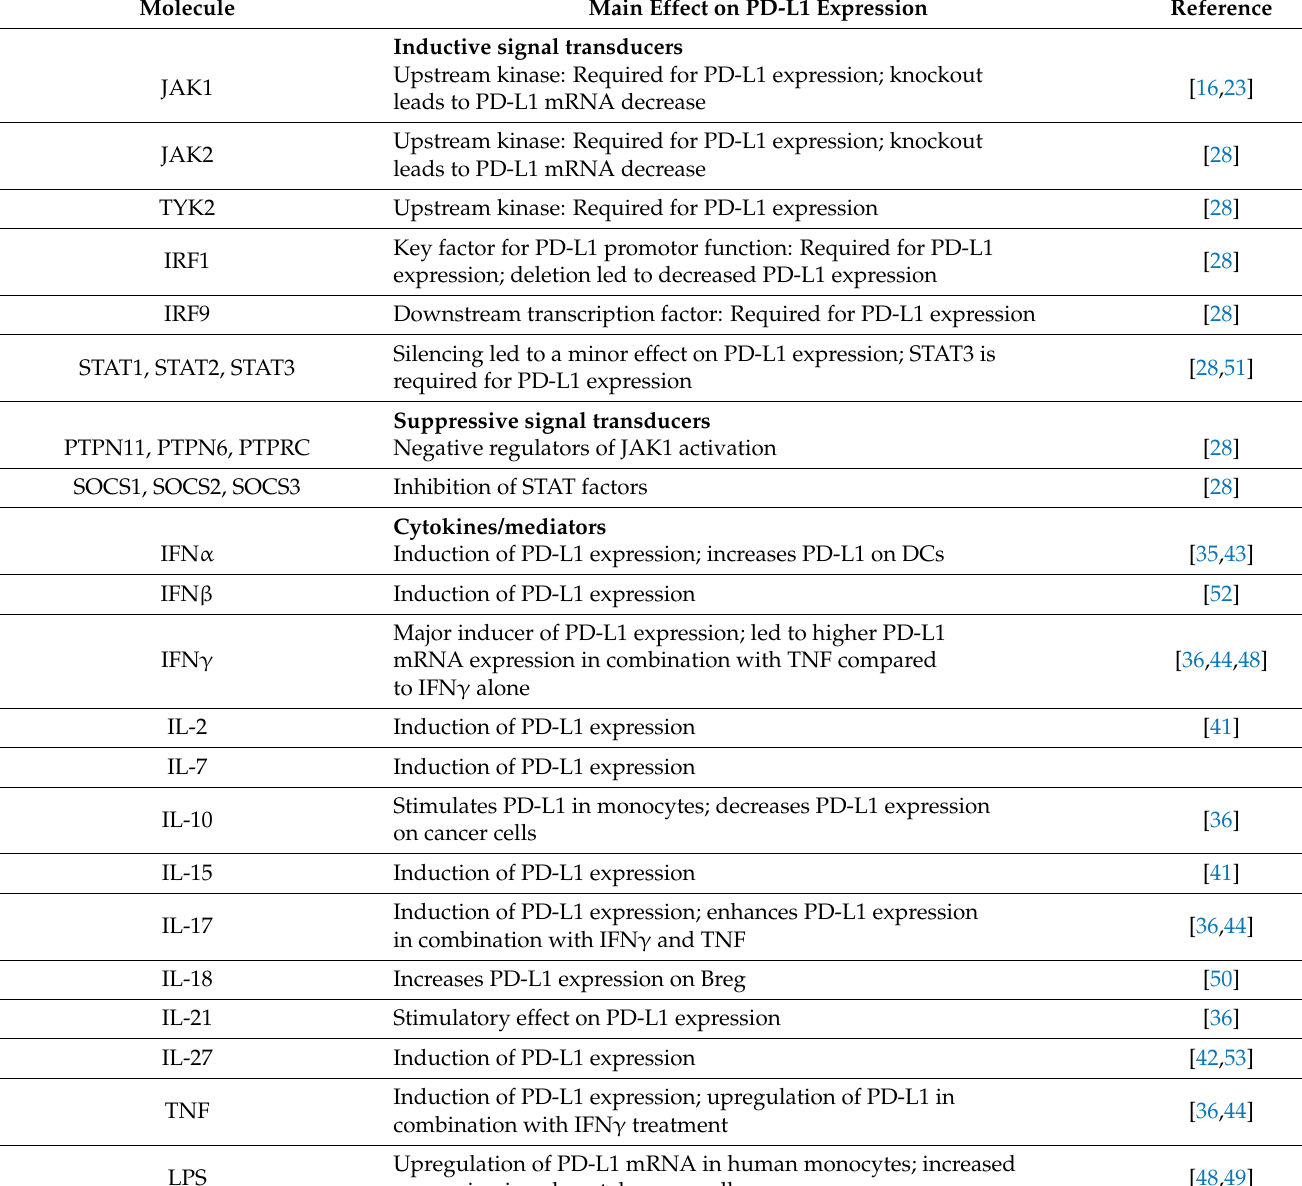
Table 1. Overview of Cytokines and Transcription Factors Relevant for Regulation of PD-L1